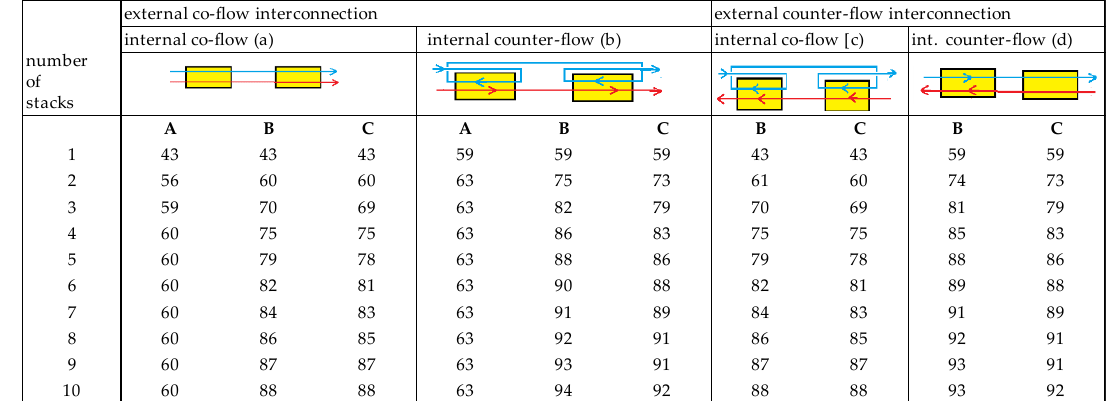
Figure 9. Energy efficiency in percent for the different arrangements of co-flow and counterflow